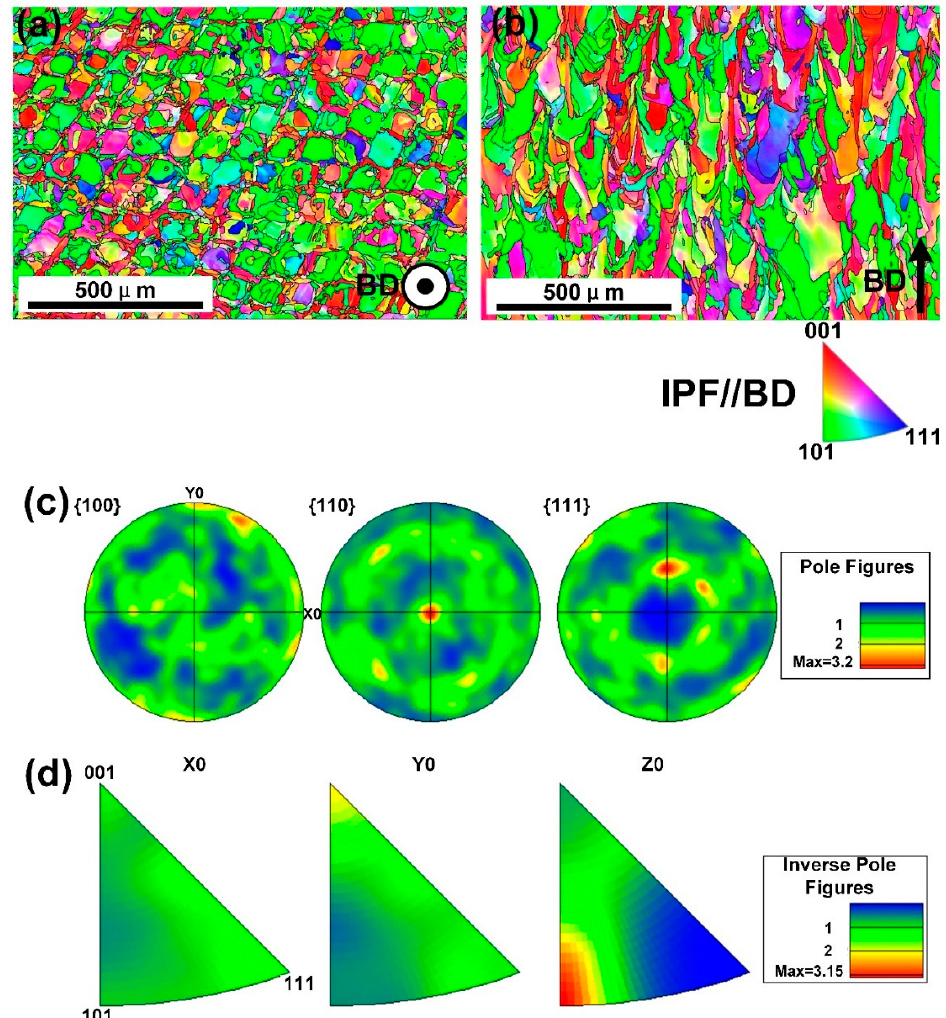
Figure 6. Electron backscatter di ff raction (EBSD) orientation maps showing grain morphologies for the SLM processed CoCrFeMnNi samples on the ( a ) top XOY plane and ( b ) side XOZ plane with the EBSD ( c ) pole figure and ( d ) inverse pole figure from XOY plane.